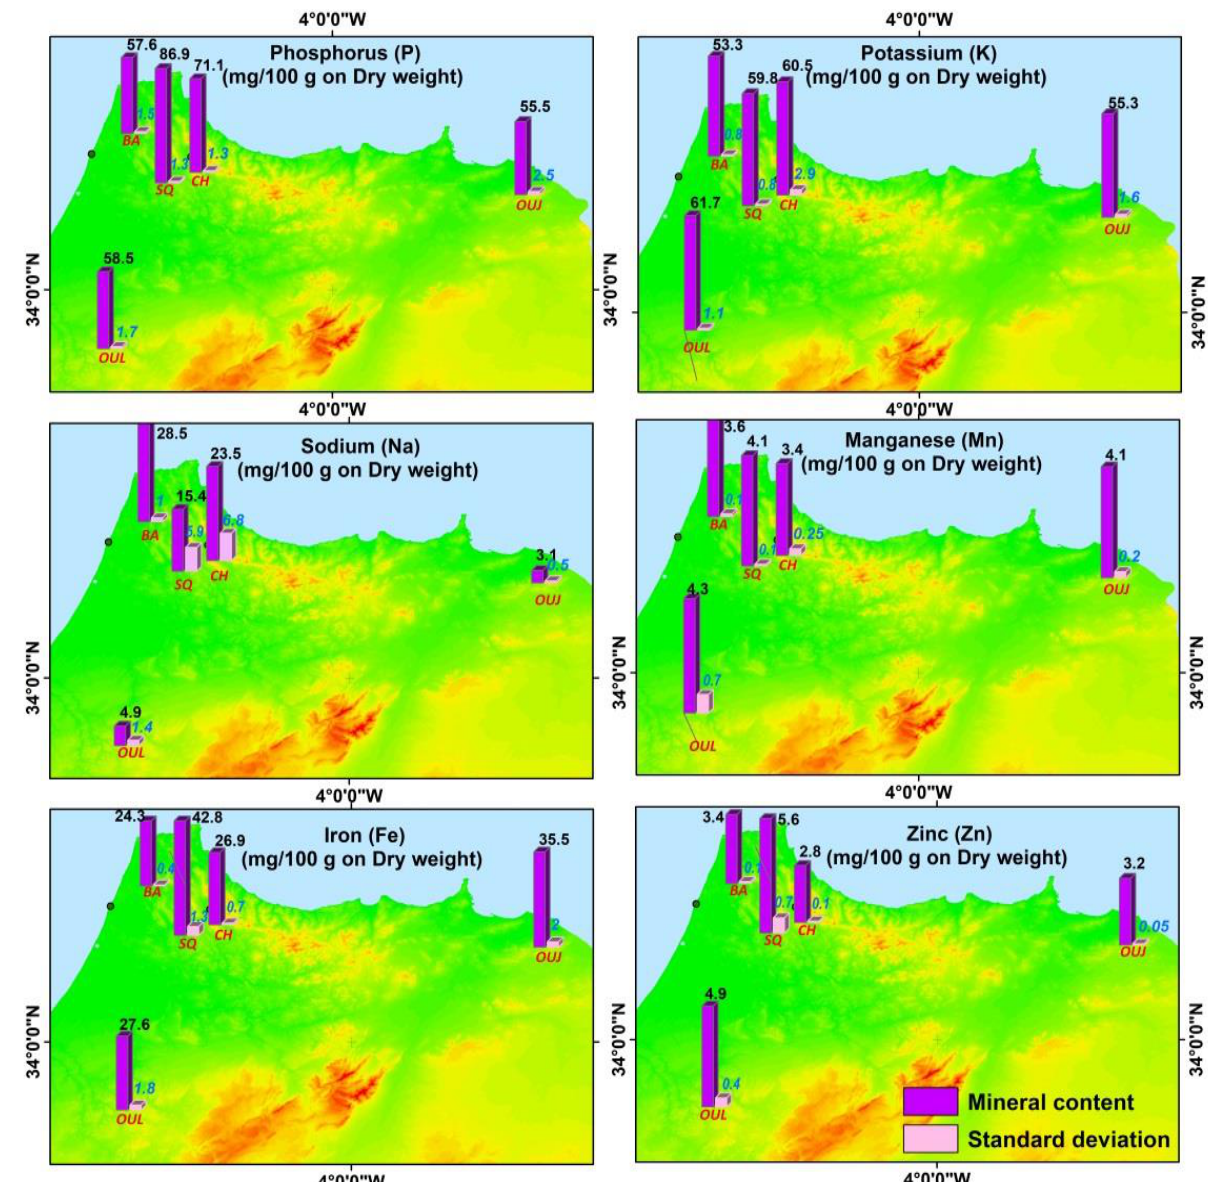
Figure 5. Geographical distribution of average mineral content and standard deviation on the surveyed area.